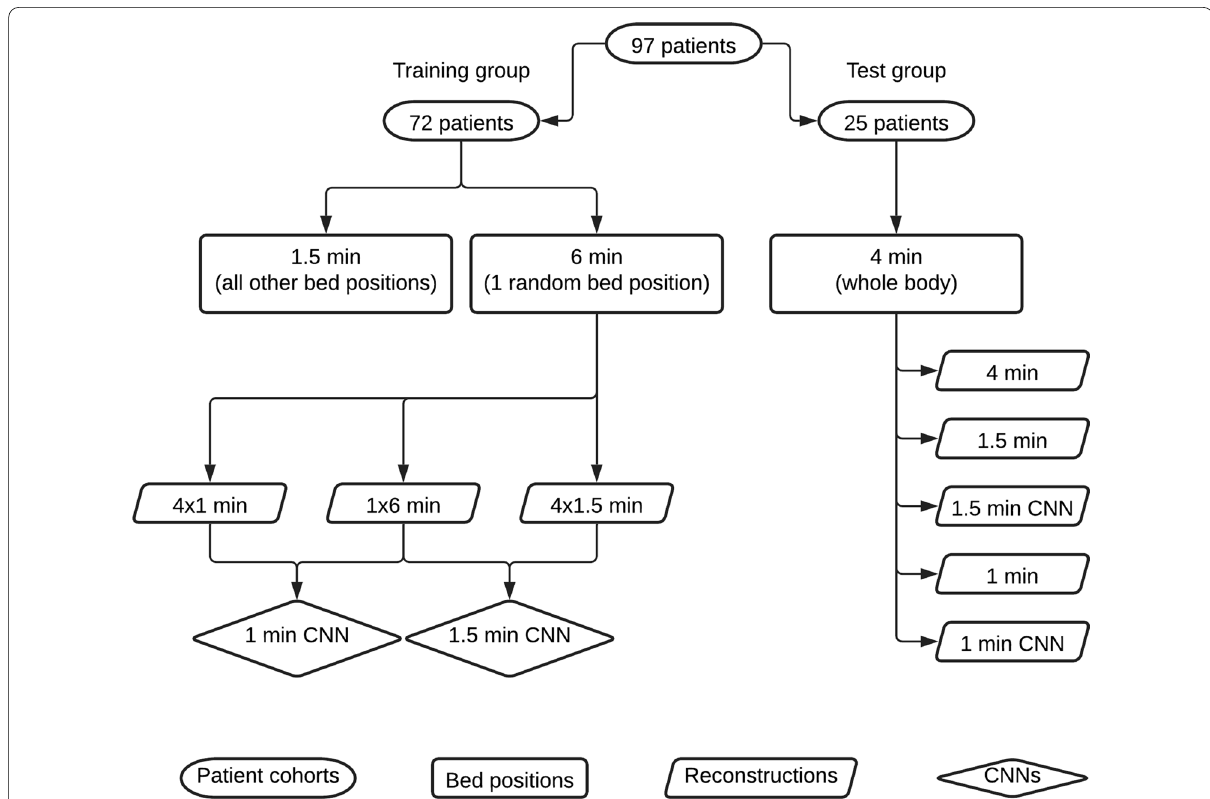
Fig. 2 Diagram showing the scan time per bed positions and the derived BSREM reconstructions. The training group produces two networks (1 min CNN and 1.5 min CNN), these are applied on whole body reconstructions (1 min CNN and 1.5 min CNN) in the test group